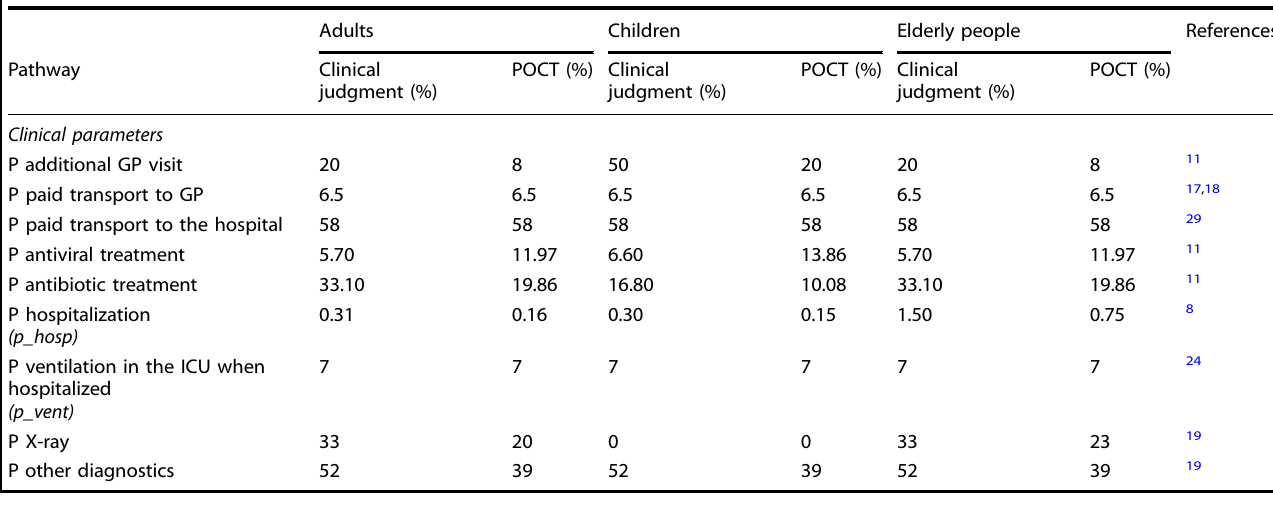
Table 1. Clinical